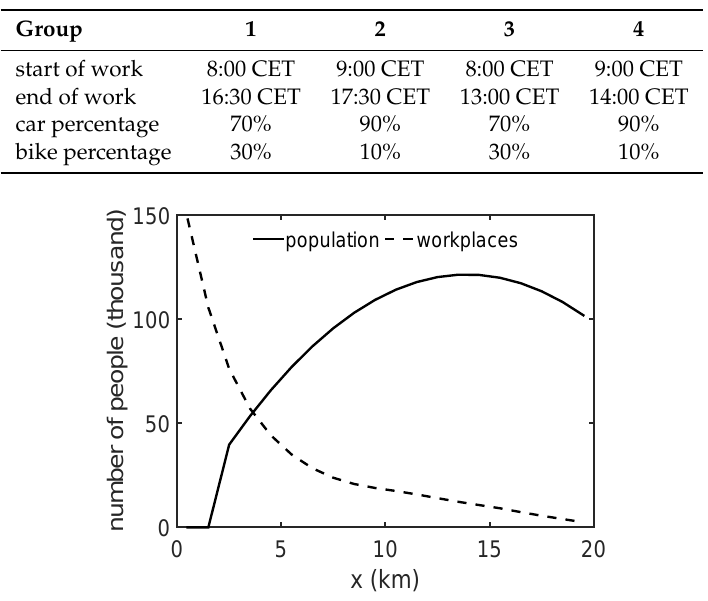
Figure 7. Distribution of the population and workplaces as a function of distance to the CBD for the simplified city with the reference case